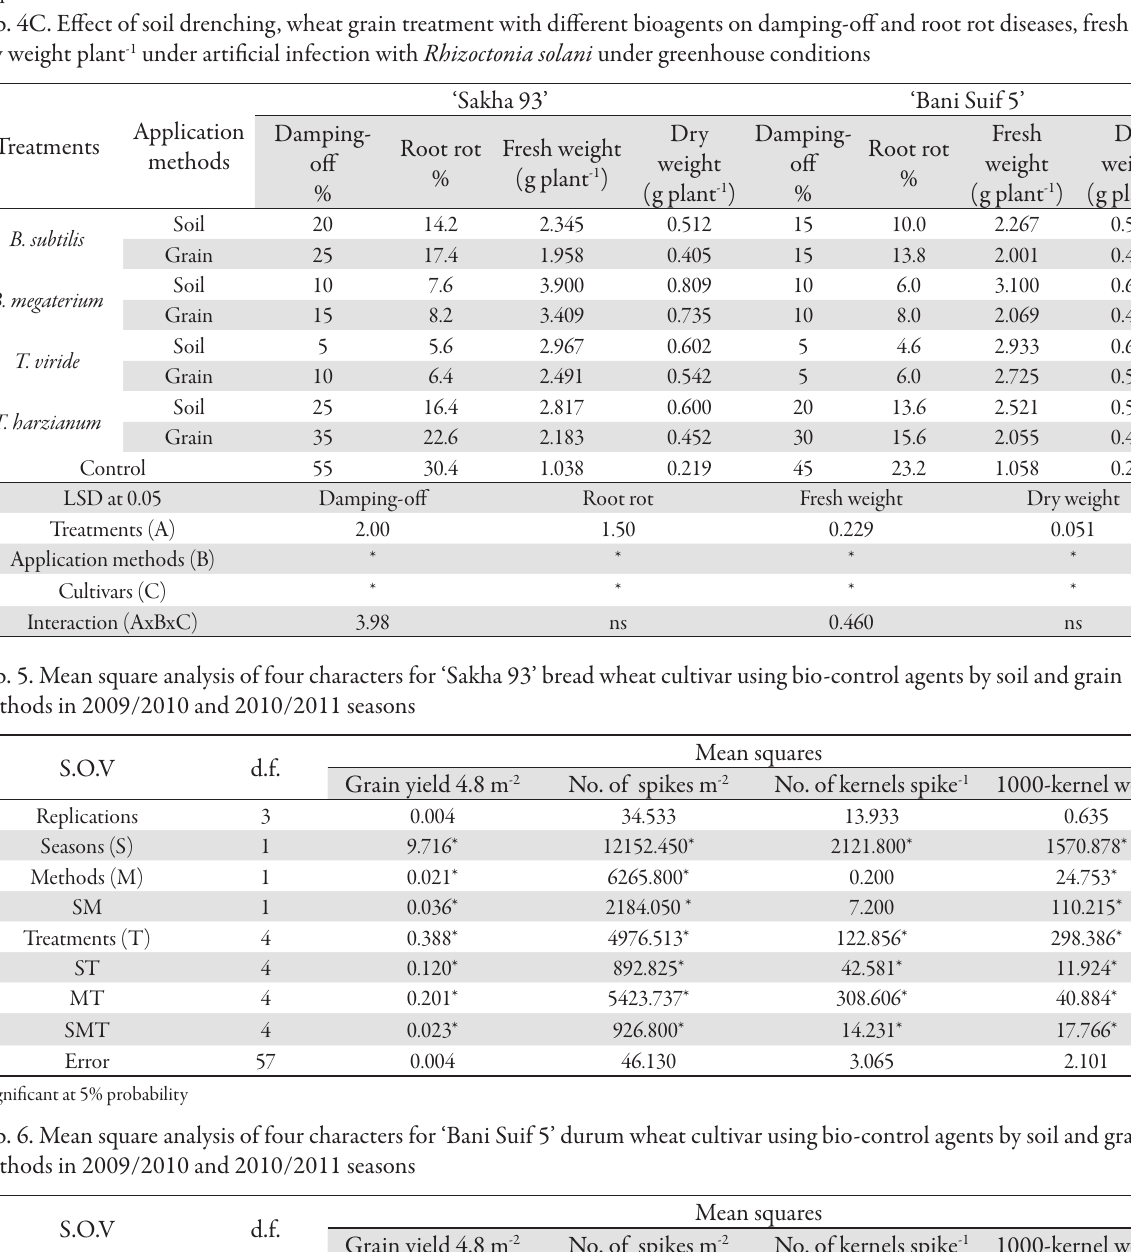
Tab. 4C. Effect of soil drenching, wheat grain treatment with different bioagents on damping-off and root rot diseases, fresh and dry weight plant -1 under artificial infection with Rhizoctonia solani under greenhouse conditions